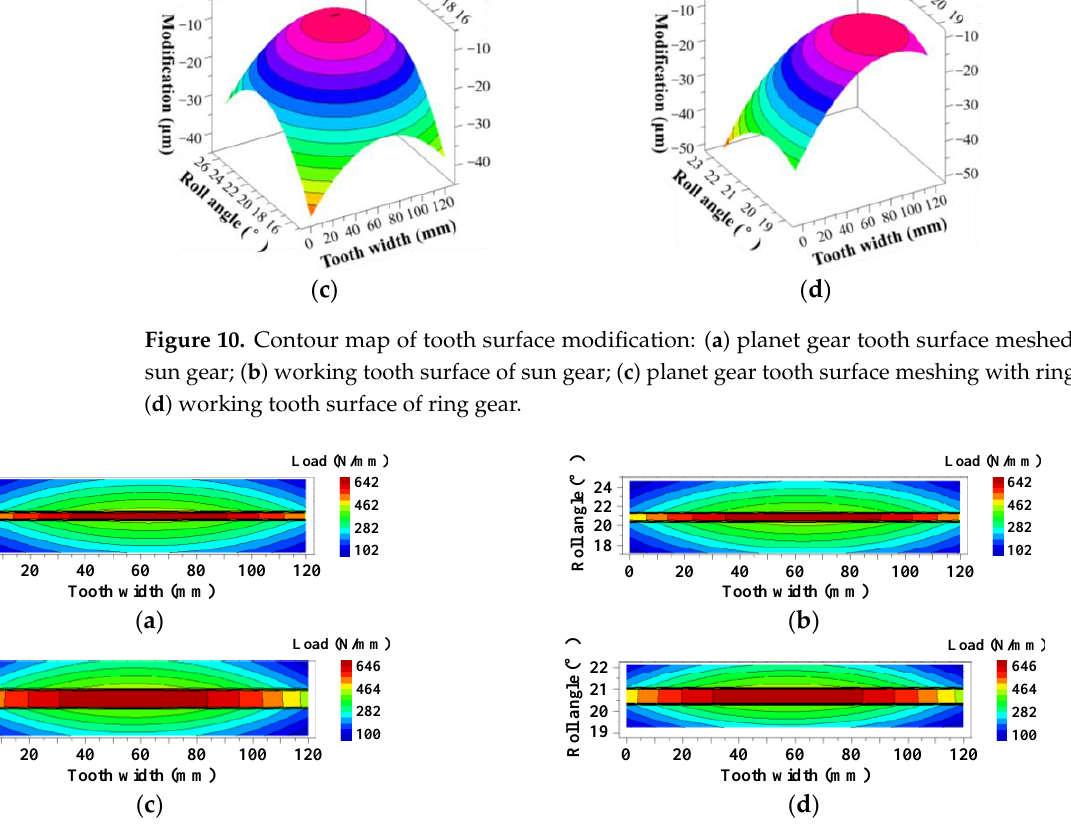
Figure 11. Load line on tooth surface: ( a ) planet gear tooth surface meshed with sun gear; ( b ) working tooth surface of sun gear; ( c ) planet gear tooth surface meshing with ring gear; ( d ) working tooth surface of ring gear.